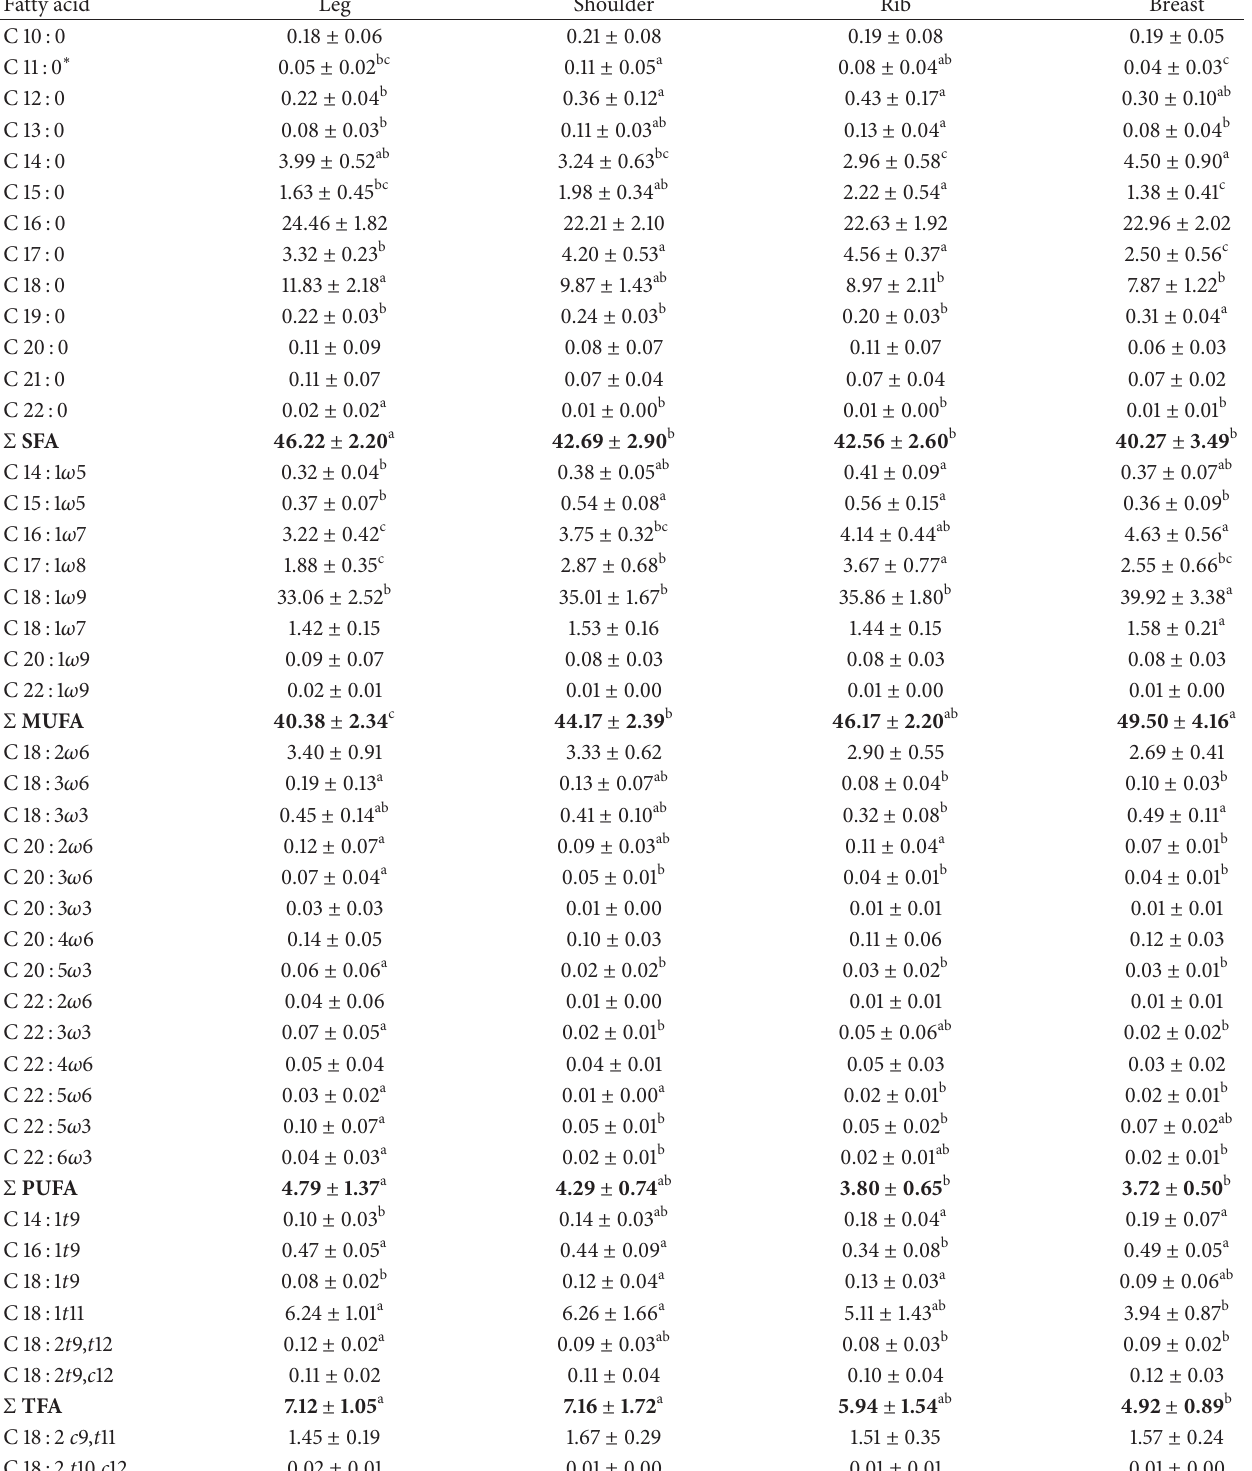
Table 2: Fatty acid composition of different carcass parts of Da˘glıc¸ (g/100g total fatty